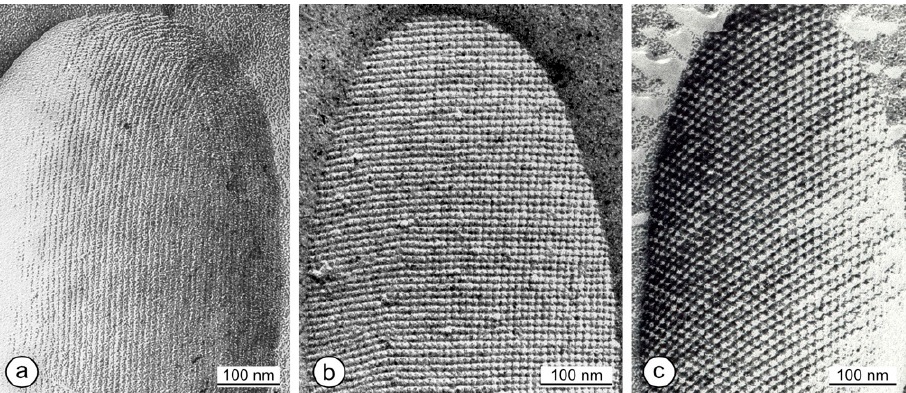
Figure 1. TEM images of freeze-etched metal shadowed preparations of ( a ) Geobacillus stearothermophilus NRS 2004-3a exhibiting an S-layer with oblique lattice symmetry (reproduced with permission from Reference [23]; published by Elsevier, 1986), ( b ) Desulfotomaculum nigrificans B200-71 exhibiting an S-layer with square lattice symmetry (reproduced with permission from Reference [24]; published by Springer|Nature, 1986), ( c ) Thermoanaerobacter Thermohydrosulfuricus L111-69 exhibiting an S-layer with hexagonal lattice symmetry (reproduced with permission from Reference [25]; published by Springer|Nature, 1989).